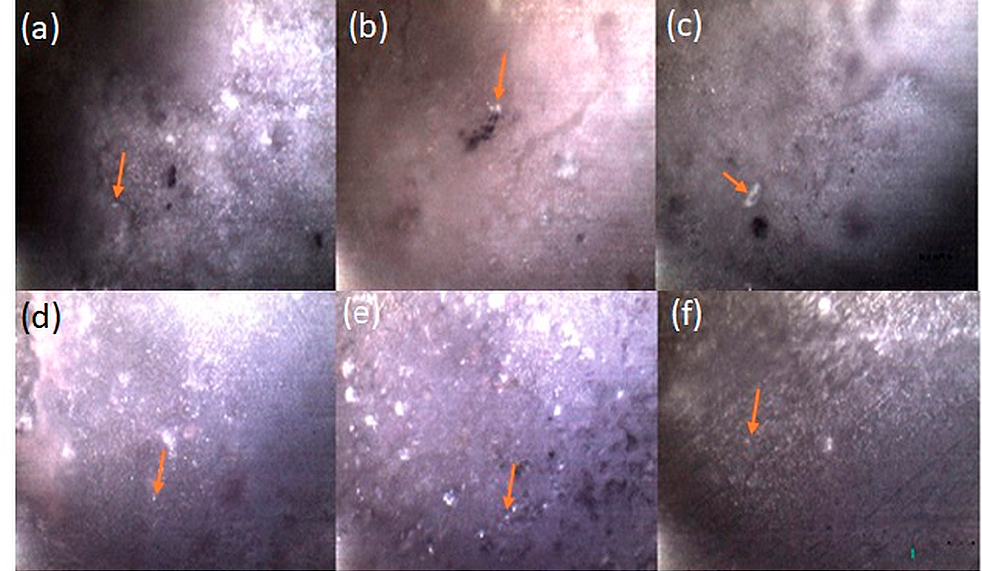
Figure 5. Optical microscopic images of Mg–HA discs at ( a ) 30 min, ( b ) 2 h and ( c ) 6 h and Mg–HA-coated samples at ( d ) 30 min, ( e ) 2 h and ( f ) 6 h of Mg–HA. Arrows indicate the presence of S. aureus on substrate surface. Scale bar ~150 µm.